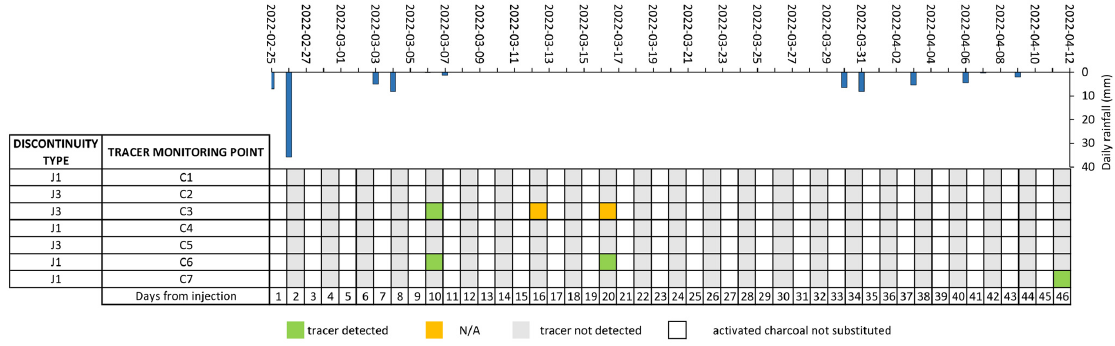
Figure 9. Tracer test results with details about detection points and location of tracer traps within discontinuities. The graph reports in the upper part the daily rainfall values in millimeters recorded from the day of injection (25 February 2022).